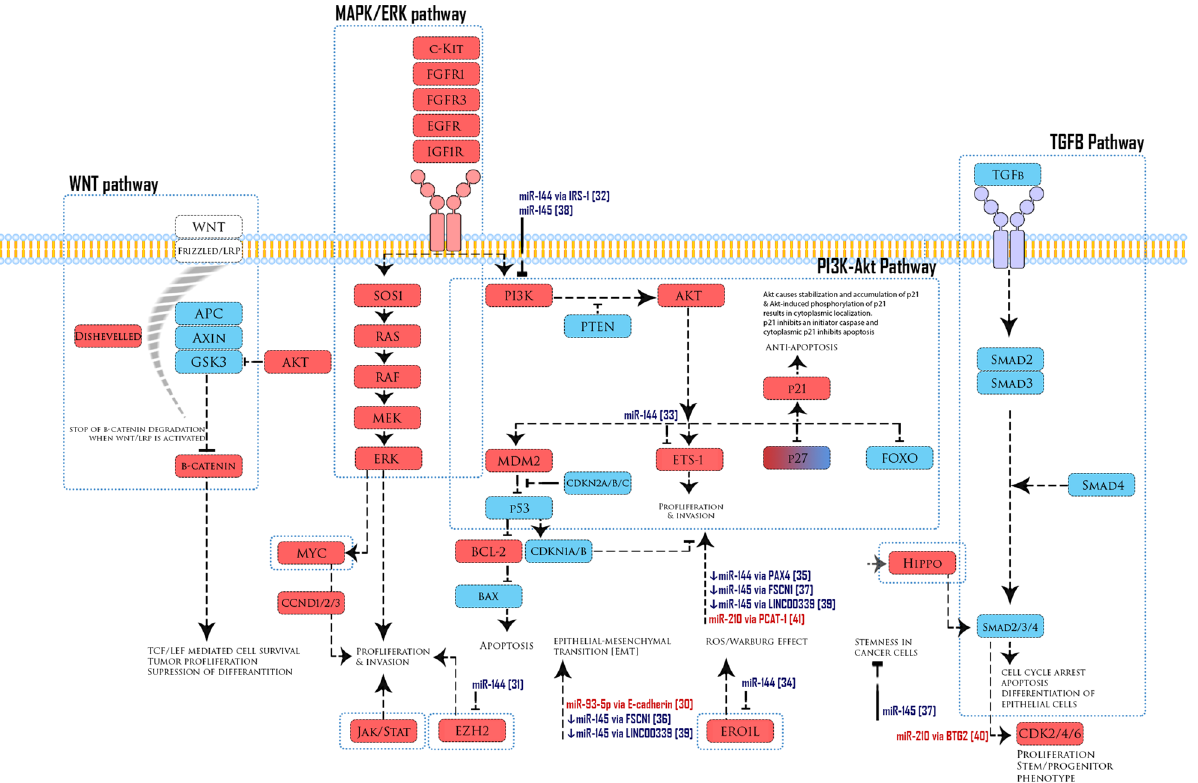
Figure 5. Illustration of some major cascades in cancer with a summary of all validated targets of miR-93-5p, miR-210-3p, miR-144-3p, and miR 145-5p in laryngeal carcinoma published in the literature. Blue color designates tumor suppressor genes, red color—oncogenes and references are given in